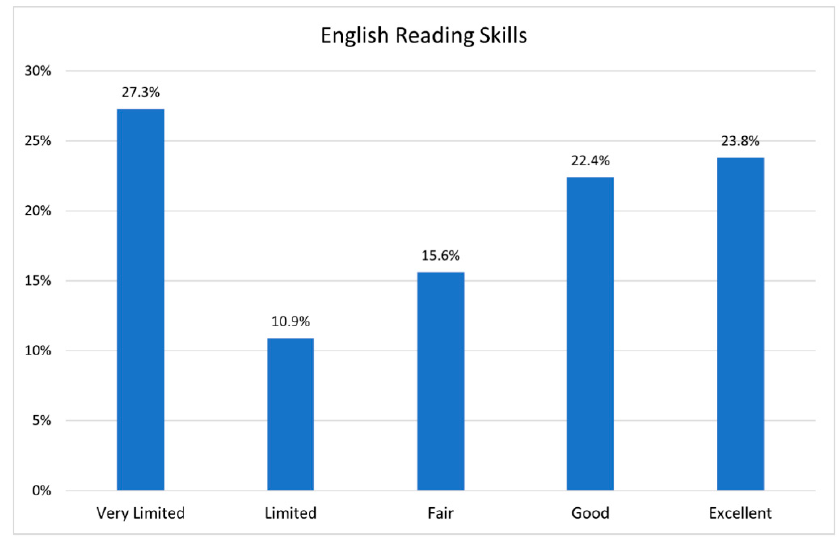
Figure 5. English reading skills of the participants.